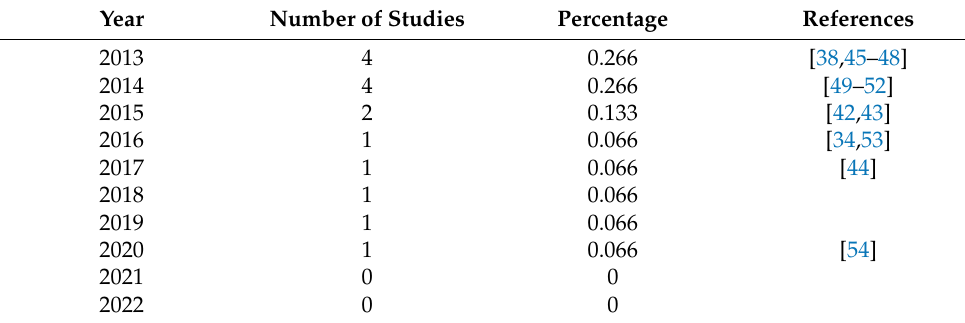
Table 3. Percentage of total studies published, by year.